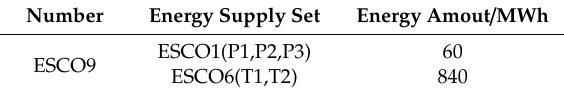
Table 7. Simulation results of ESCO9 in the EBN.